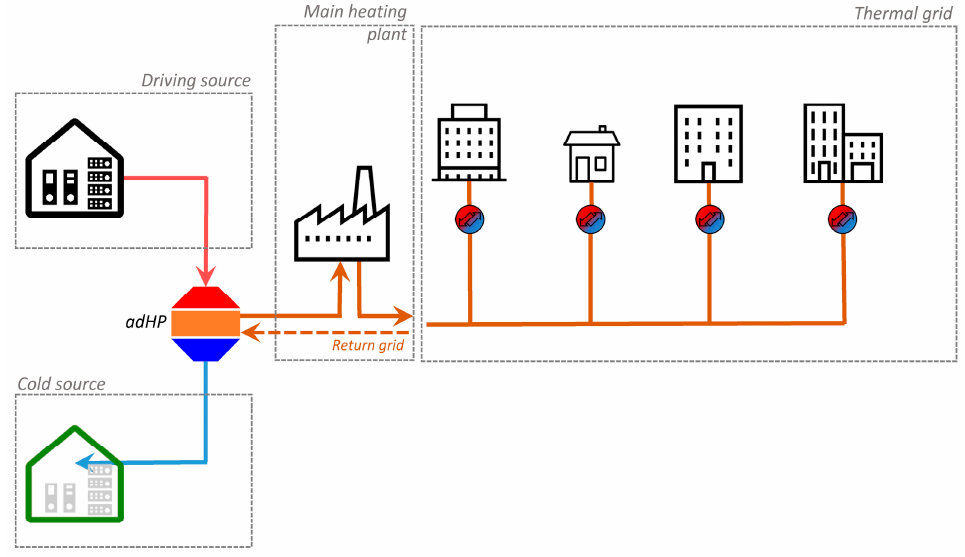
Figure 7. Schematic representation of the scenario 4. Figure 8. Schematic representation of the scenario